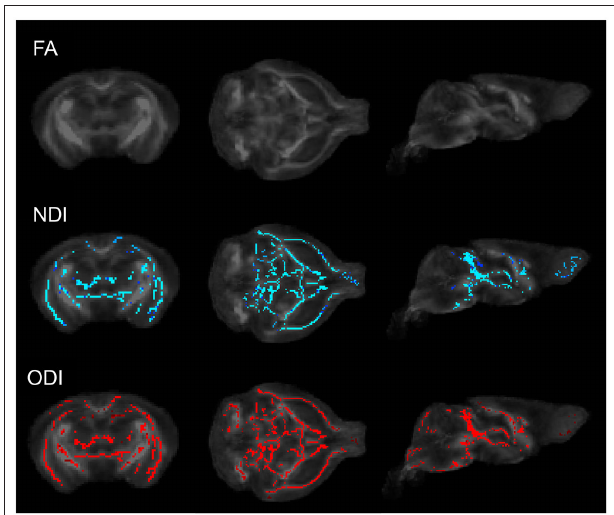
FIGURE 1 | Coronal (left), axial (middle), and sagittal (right) TBSS plots of voxelwise changes in FA, NDI, and ODI between GF and HG P55 male animals. No significant voxelwise differences in fractional anisotropy (FA) were identified; however, TBSS analyses uncovered significant voxelwise reductions in both neurite density (NDI) and orientation dispersion (ODI) in GF mice when compared to HG mice. At P90, no significant voxelwise differences in NDI or ODI were detected between HG and GF